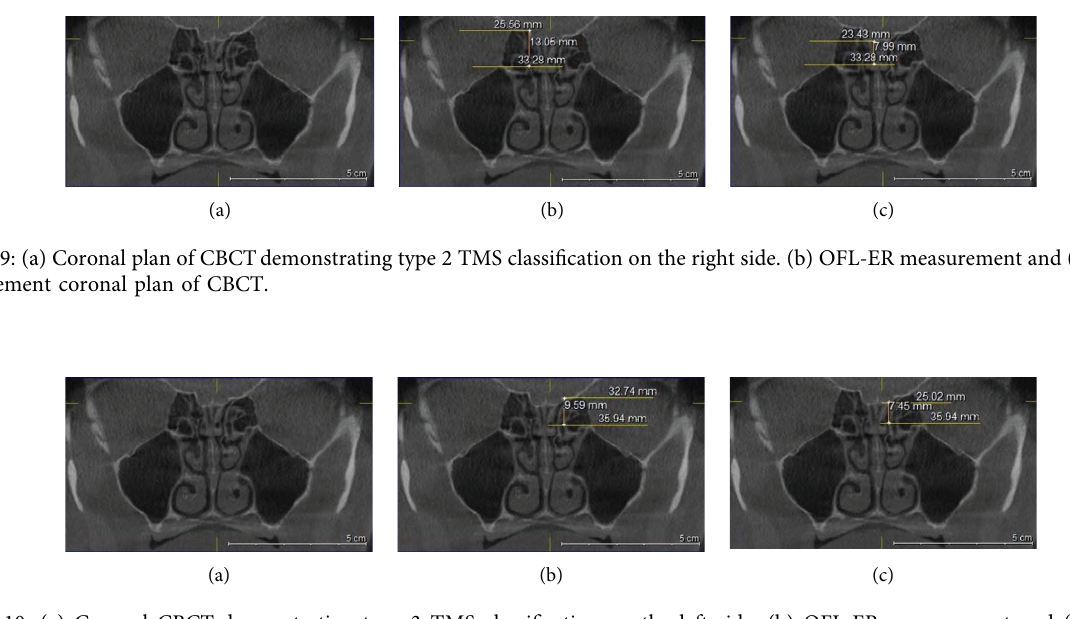
Figure 10: (a) Coronal CBCT demonstrating type 3 TMS classification on the left side. (b) OFL-ER measurement and (c) OFL-CP measurement coronal plan of